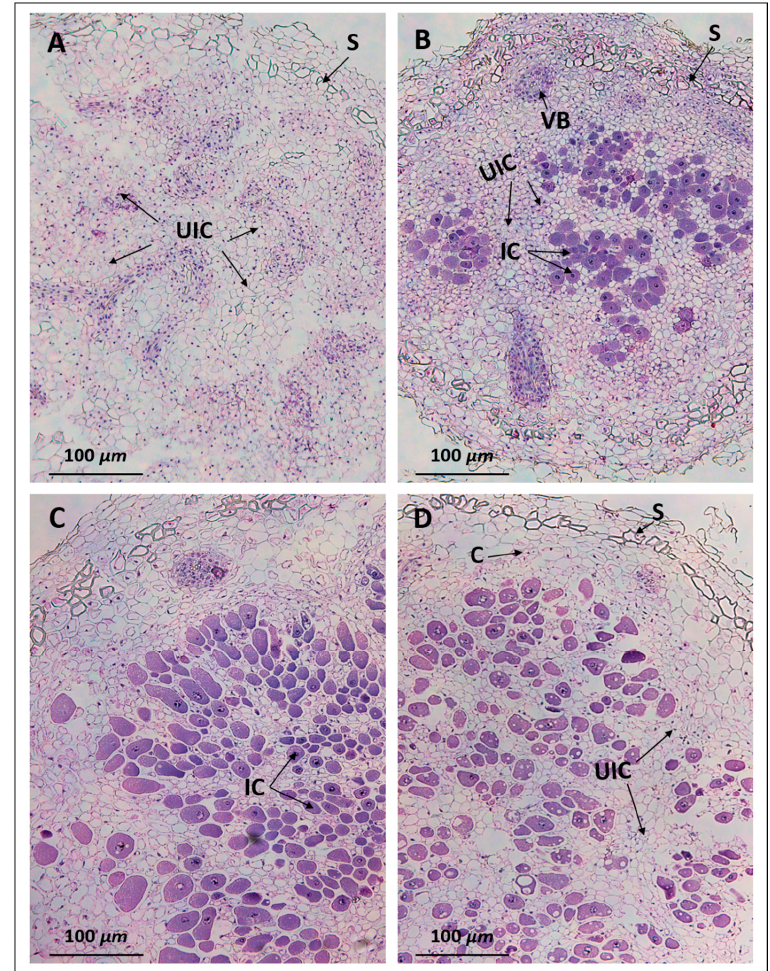
Figure 4. Light micrographs of nodules. Pigeon pea nodules collected at 30 days after inoculation (DAI) were embedded in paraffin. Nodule sections were stained with hematoxylin and eosin. Note the nodules initiated by B. diazoefficiens USDA110 ( A ) contain only uninfected cells, while those inoculated with B. diazoefficiens Δ 136 ( B ), S. fredii USDA191 ( C ), and S. fredii USDA RCB26 ( D ) revealed a distinct central infection zone. VB, vascular bundle; S, scleroid layer; UIC, uninfected cell; C, cortex.